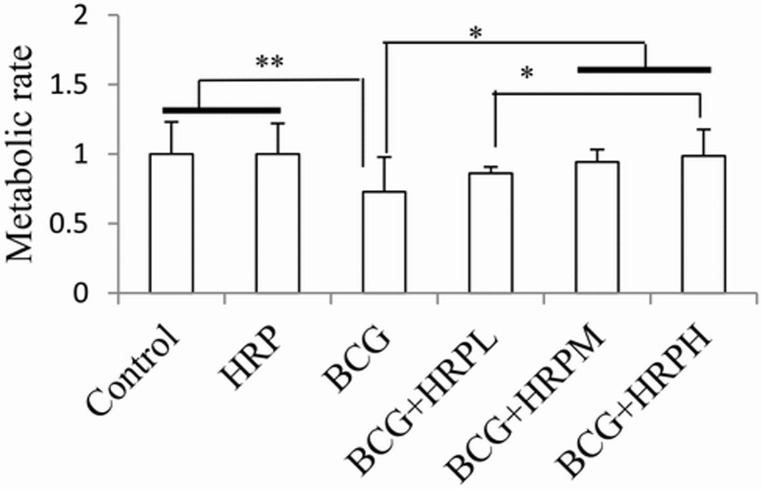
Effect of HRP on CYP3A metabolic activity in microsomes from rat liver following immune-mediated injury.Metabolic rate was indicated by the ratio of 1-hydroxymidazolam to midazolam after in vitro incubation with microsomes and weighted by the control group. Data represent means ± SD of n = 10 rats. Asterisks stars above bars indicate differences between groups.